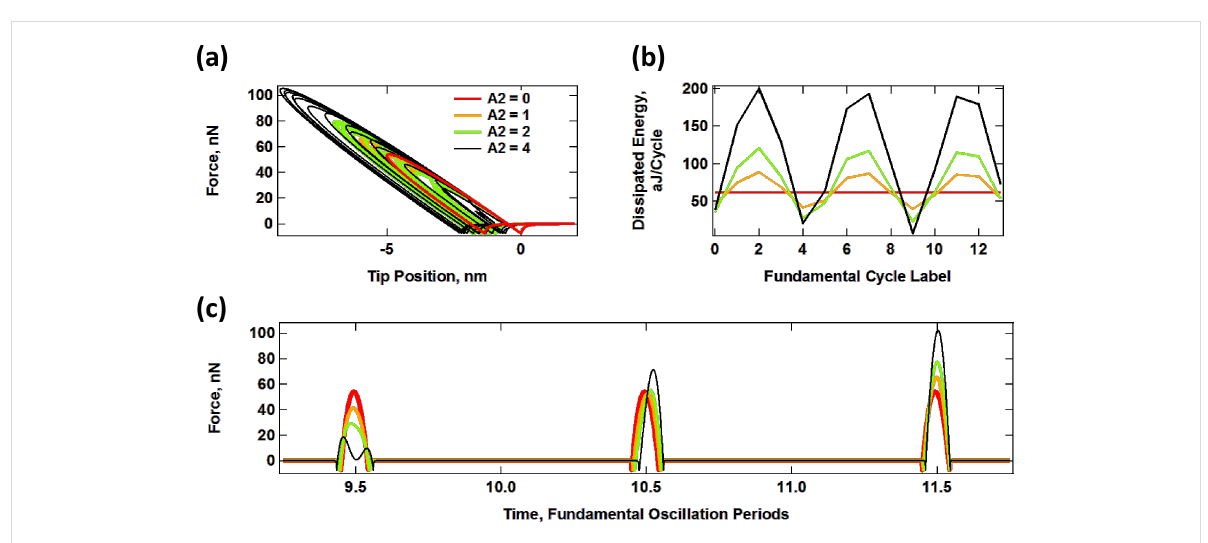
Figure 6: Interaction of an SLS surface with a probe oscillating along a prescribed bimodal trajectory of variable maximum penetration, given by z tip ( t ) = 95 nm + (100 nm)·cos( ω 1 t ) + A 2 ·cos(6.21· ω 1 t ), with ω 1 = 2 π (50 kHz), K inf = K o = 7.5 N/m and C diss = 1 × 10 − 5 N·s/m. (a) Force–distance trajectories for varying A 2 ; (b) dissipated energy per cycle for successive fundamental cycles and varying A 2 ; (c) example of successive